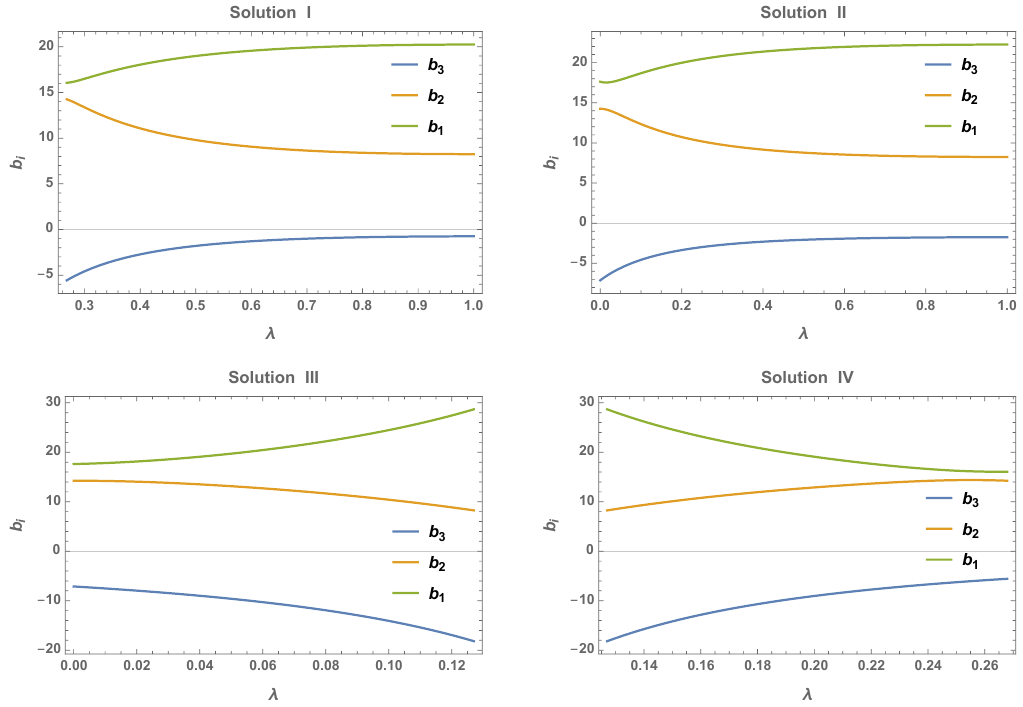
Figure 3 . The eigenvalues b i in eq. (4.22) as a function of the deformation parameter λ . The upper left plot refers to the solution I, the upper right to the solution II, the lower left to the solution III and the lower right to the solution IV. In all cases there is a negative eigenvalue, namely the b 3 , signaling the existence of an unstable